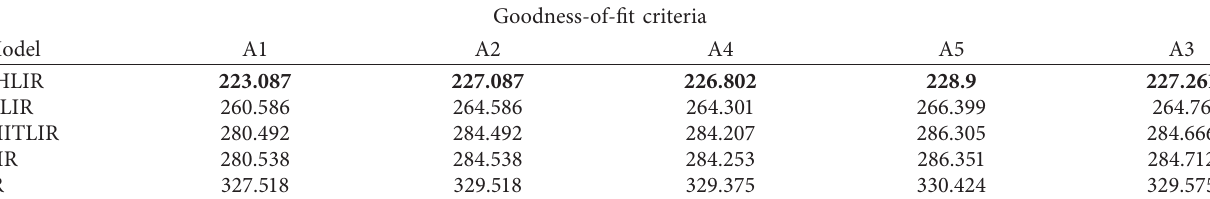
Table 5: The values of A1, A2, A3, A4, and A5 for data